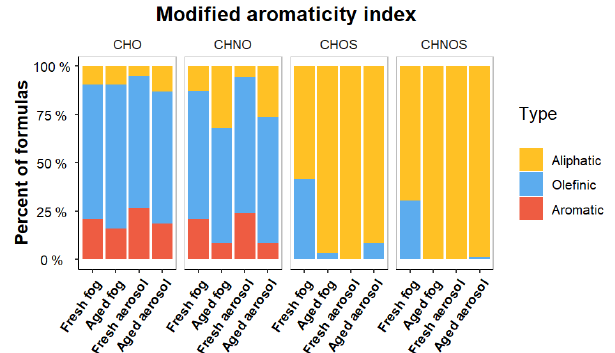
Figure 4. The modified aromaticity index (AI mod ) for the assigned molecular formulas (Eqs. 5–7) and the percentage of each AI mod type, as defined by Koch and Dittmar (2016): aliphatic (AI mod = 0), olefinic (0<AI mod ≤ 0 . 5), aromatic (AI mod >0.5), and condensed aromatic (AI mod ≥ 0 . 67). Here aromatic and condensed aromatic formulas were combined, because a small fraction of condensed aromatics was observed. The results are partitioned by elemental group, where it can be seen that the majority of olefinic and aro- matic compounds belong to the CHO and CHNO groups. The sam- ple names fresh fog, aged fog, fresh aerosol, and aged aerosol corre- spond to SPC0106F, SPC0201F, BO0204N, and BO0213D, respec-